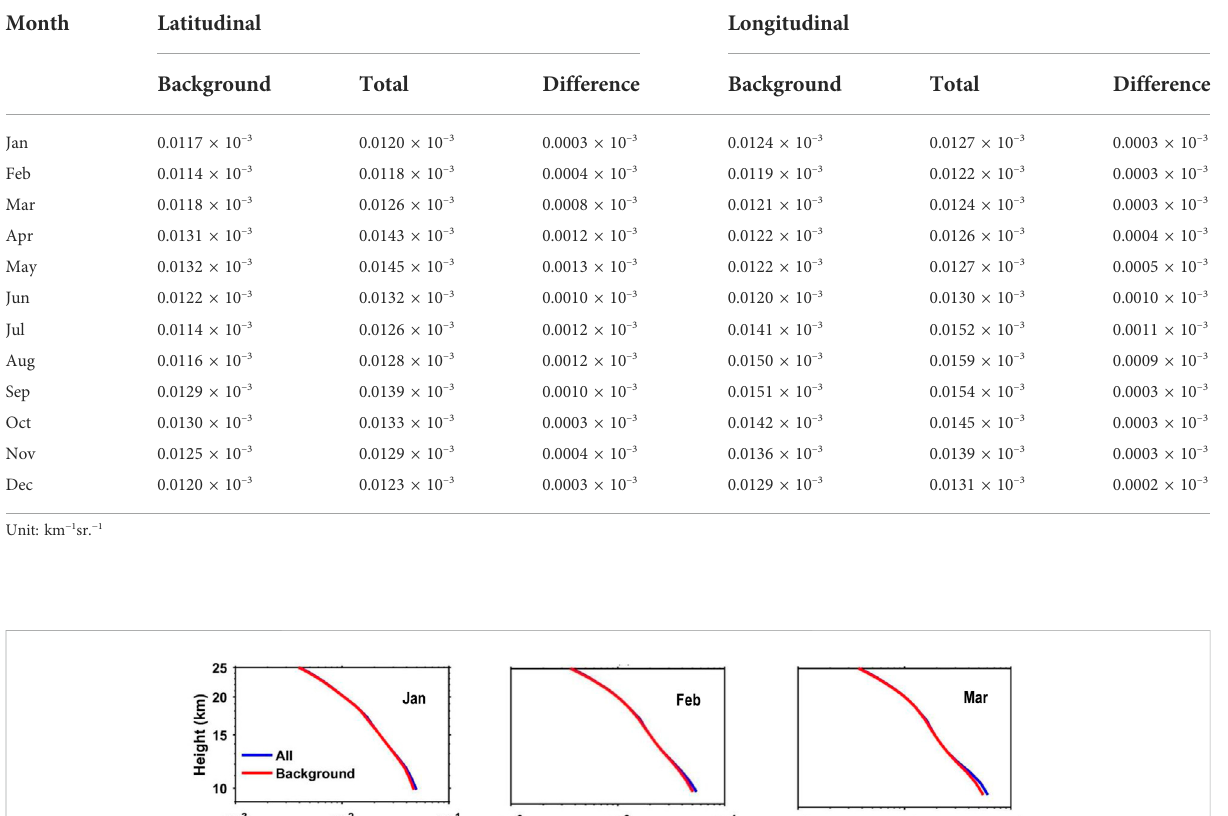
TABLE 2 Mean background and total aerosol particulate backscatter values over Xinjiang from 2007 to 2018 by month.